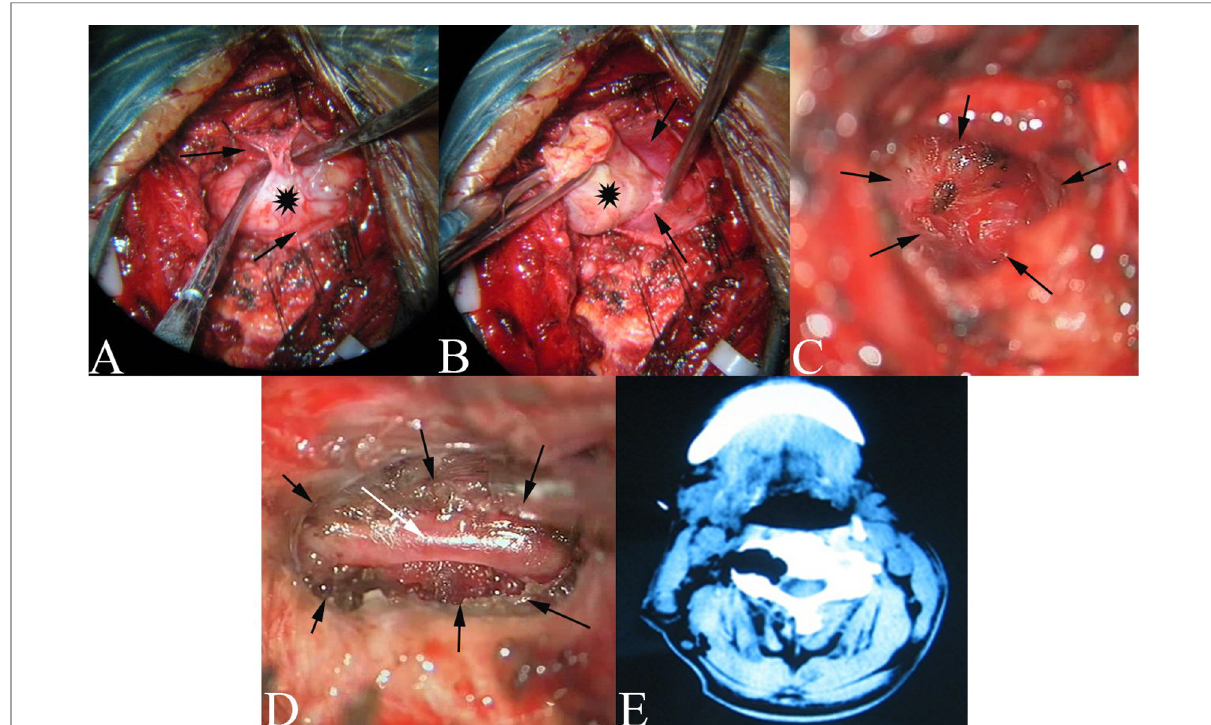
FIGURE 4 ( A ): the paraspinal tumor was dissected from the capsule, Black Asterisk: tumor; Black Arrow: Capsule of tumor. ( B ): The tumor was dissected in enlarged intervertebral for amen from the capsule. Black Asterisk: tumor; Black Arrow: Capsule of tumor ( C ): Bulging of the translucent membranous. Black arrow: Enlarged interertebral foramen. ( D ): The VA (white arrow)in the enlarged intervertebral foramen (black arrow) after tumor removal. ( E ): The CT of